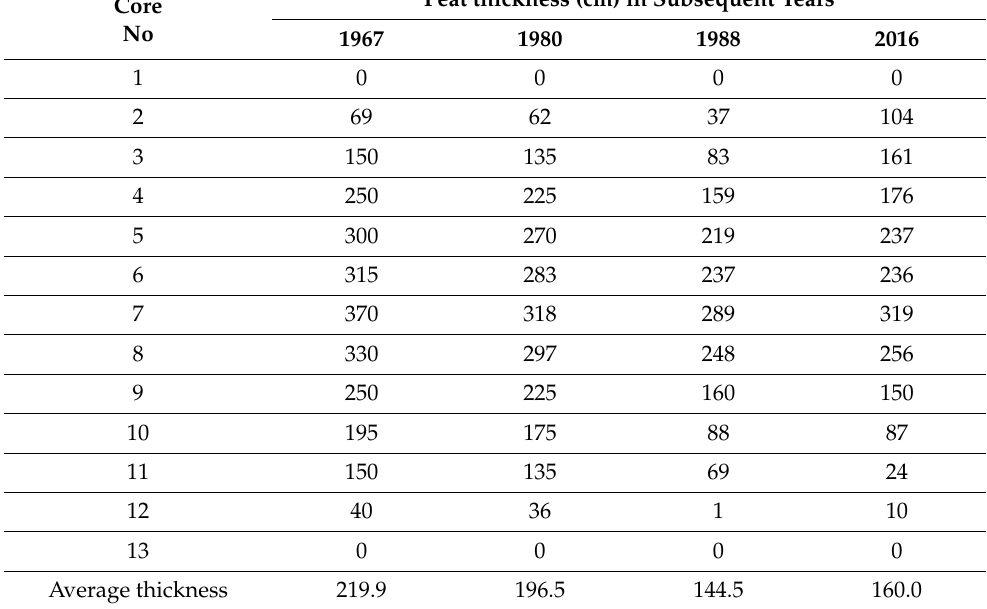
Table 1. Changes in thickness in the characteristic A-B transect of the “Wołosate” bog dome (Western Bieszczady Mountains) in the years